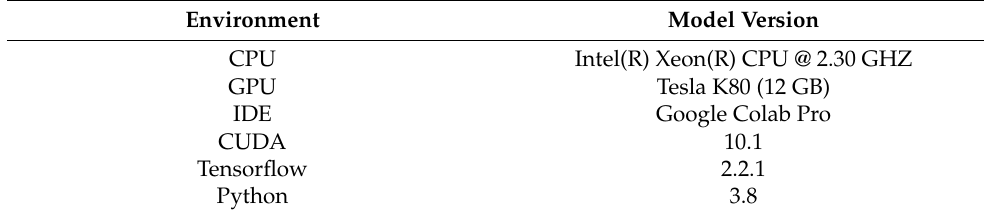
Table 4. Training hardware